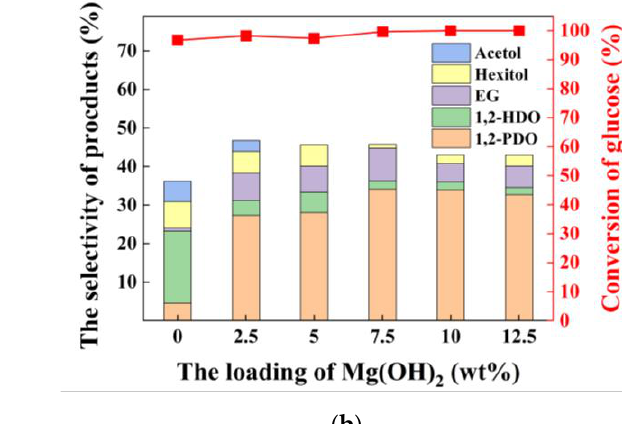
Figure 3. The effect of Mg(OH) 2 loading on hydrogenolysis of glucose into 1,2-PDO. ( a ) effect of Mg(OH) 2 loading(0 – 80 wt%) on 1,2-PDO production; ( b ) effect of Mg(OH) 2 loading on 1,2-PDO production (0 – 12.5 wt%) and selectivity of production. Reaction condition: catalyst (200 mg), glucose (11.25 mg/mL, 10 mL) and H2 (initial 6 MPa) at 200 °C for 3 h.